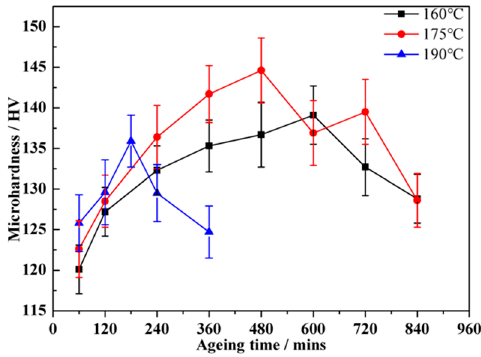
Figure 8. Micro-hardness curves of the alloy after experienced various ageing treatment